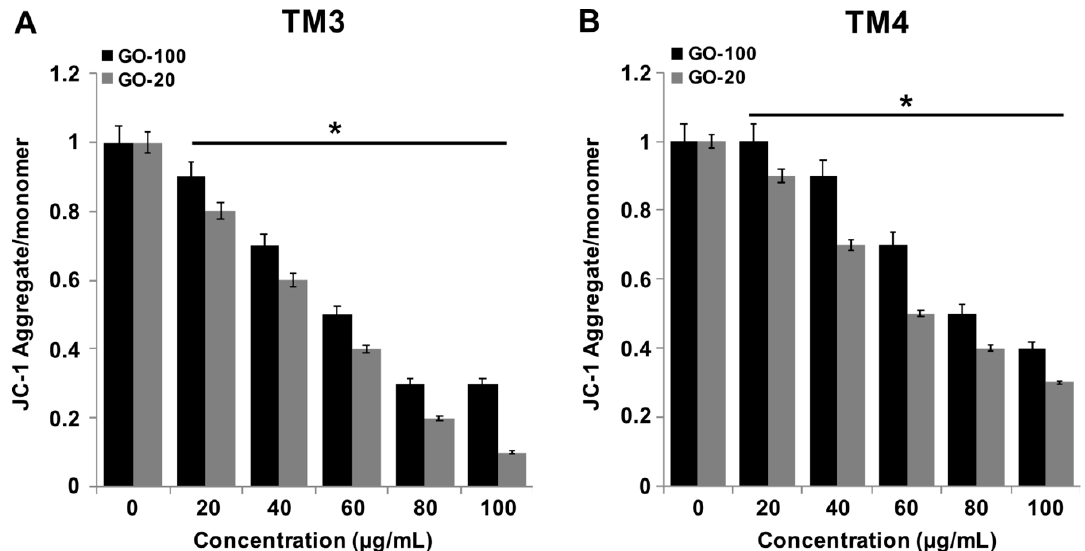
Figure 5. GO-100 and GO-20 graphene sheets impair mitochondrial membrane potential. ( A ) TM3 cells were treated with GO (20–100 μ g/mL), ( B ) GO-20 (20-100 μ g/mL) for 24 h, and the mitochondrial membrane potential (MMP) was determined using the cationic fluorescent indicator JC-1 ( B ). TM4 cells were treated with GO (20–100 μ g/mL), ( B ) GO-20 (20-100 μ g/mL) for 24 h, and